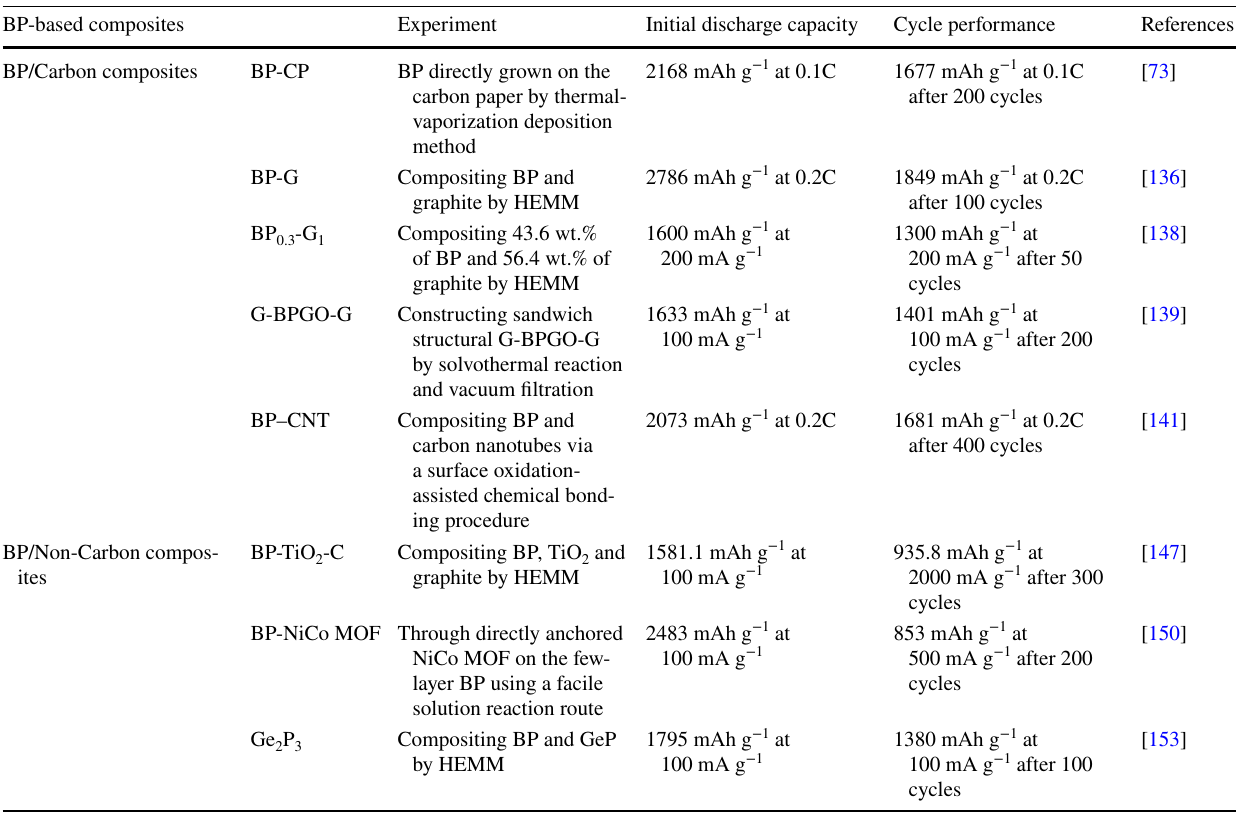
Table 2 Summary of BP-based composites as the anode of LIBs BP-based